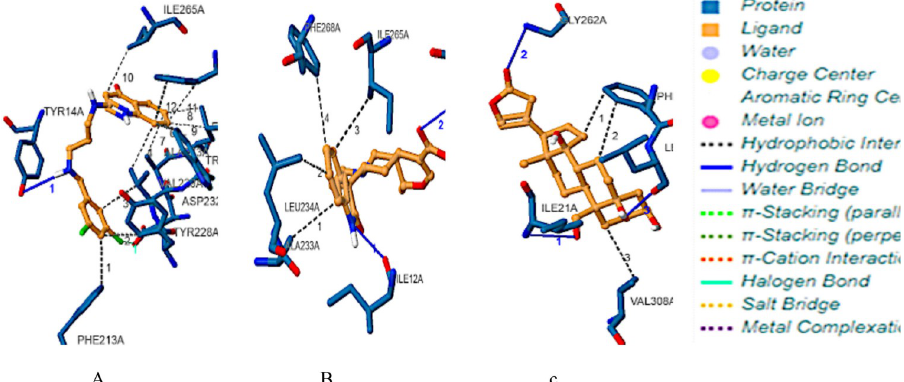
Fig 6. Interactions of target with reference and lead compounds (a) BrMelMetRS-OOU complex, (b) BrMelMetRS-Isopteropodin complex (c) BrMelMetRS-Strophanthidin complex.